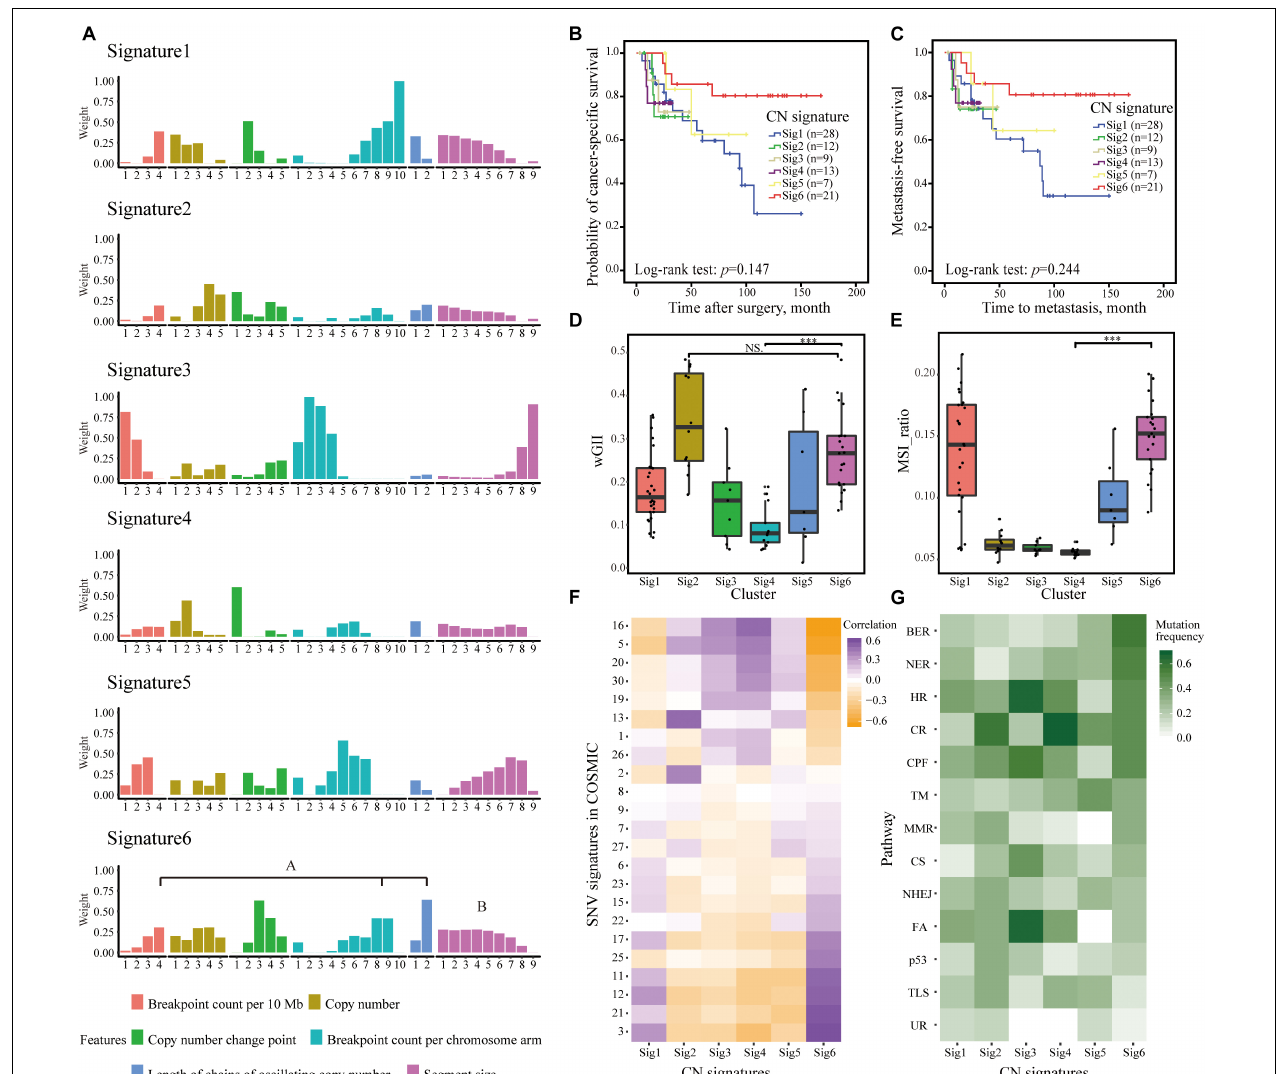
FIGURE 2 | CNAs in 90 UTUC patients defined six CN signatures. (A) The component weights for six CN signatures. The important components weights including high numbers of breakpoints, long chains of oscillating copy numbers, and fragmented genomic segments of Sig6 were highlighted. (B,C) The Kaplan–Meier analysis of cancer-specific survival (B) and metastasis-free survival (C) in the UTUC Cohort I stratified by six CN signatures. Statistical significance was determined by log-rank test. (D,E) Comparison of wGII (D) and MSI (E) among different CN signature exposures derived from WGS data. Statistical significance was determined by Wilcoxon rank test, *** p < 0.001. NS represents not significant. (F) Associations between CN signature exposures and SNV signatures in COSMIC. (G) Difference among CN signature exposures in mutations of genes involving in multiple DNA damage response pathways. AM, alternative mechanism for telomere maintenance; BER, base excision repair; CPF, checkpoint factor; CNA, copy number alteration; CR, chromatin remodeling; CS, chromosome segregation; DR, direct repair; FA, Fanconi anemia pathway; HR, homologous recombination; MMR, mismatch repair; NER, nucleotide excision repair; NHEJ, non-homologous end joining; TLS, translesion synthesis; TM, telomere maintenance; UR, ubiquitination response; CN, copy number; wGII, weighted genome integrity index score; MSI, microsatellite instability; WGS, whole-genome sequencing; SNV, single-nucleotide variation; UTUC, upper tract urothelial